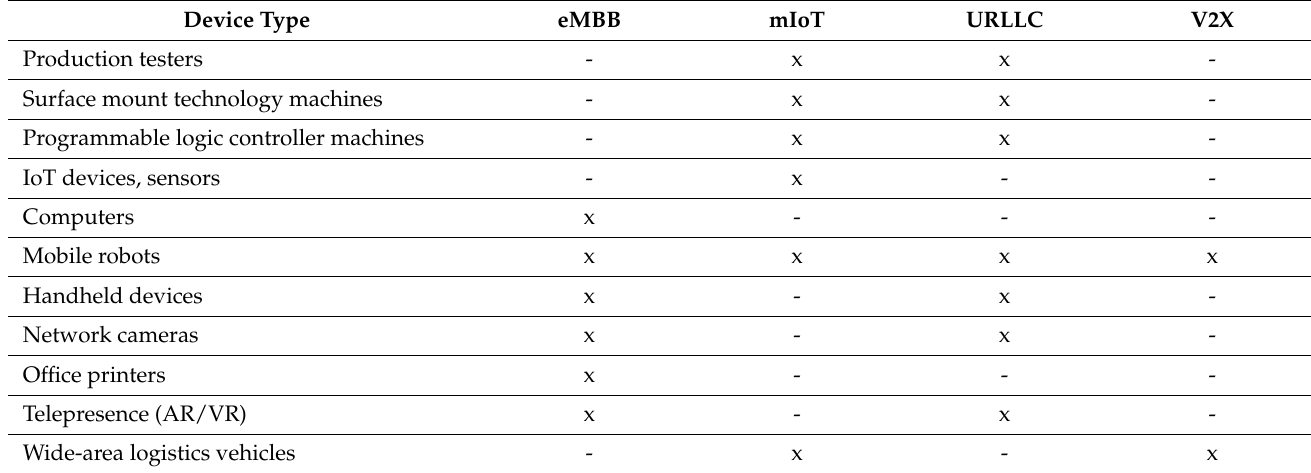
Table 2. Slice Type Allocation for the Smart Factory case.